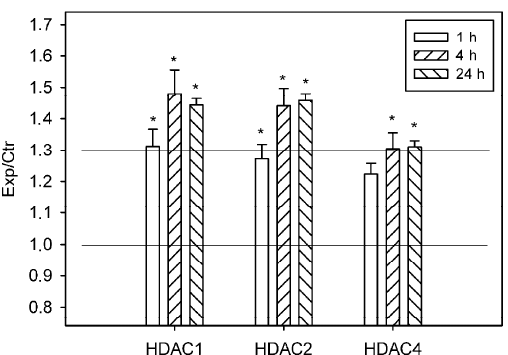
Figure 3. The ratios of levels of histone deacetylases HDAC1, HDAC2, and HDAC4 in the ischemic penumbra 1, 4, or 24 h after photothrombotic stroke in the rat cerebral cortex (Exp) to that in the untreated contralateral cortex of the same animals (Ctr). The antibody microarray data. n = 16 (4 animals × 4 values in each experiment). Mean ± SD. * p < 0.05.